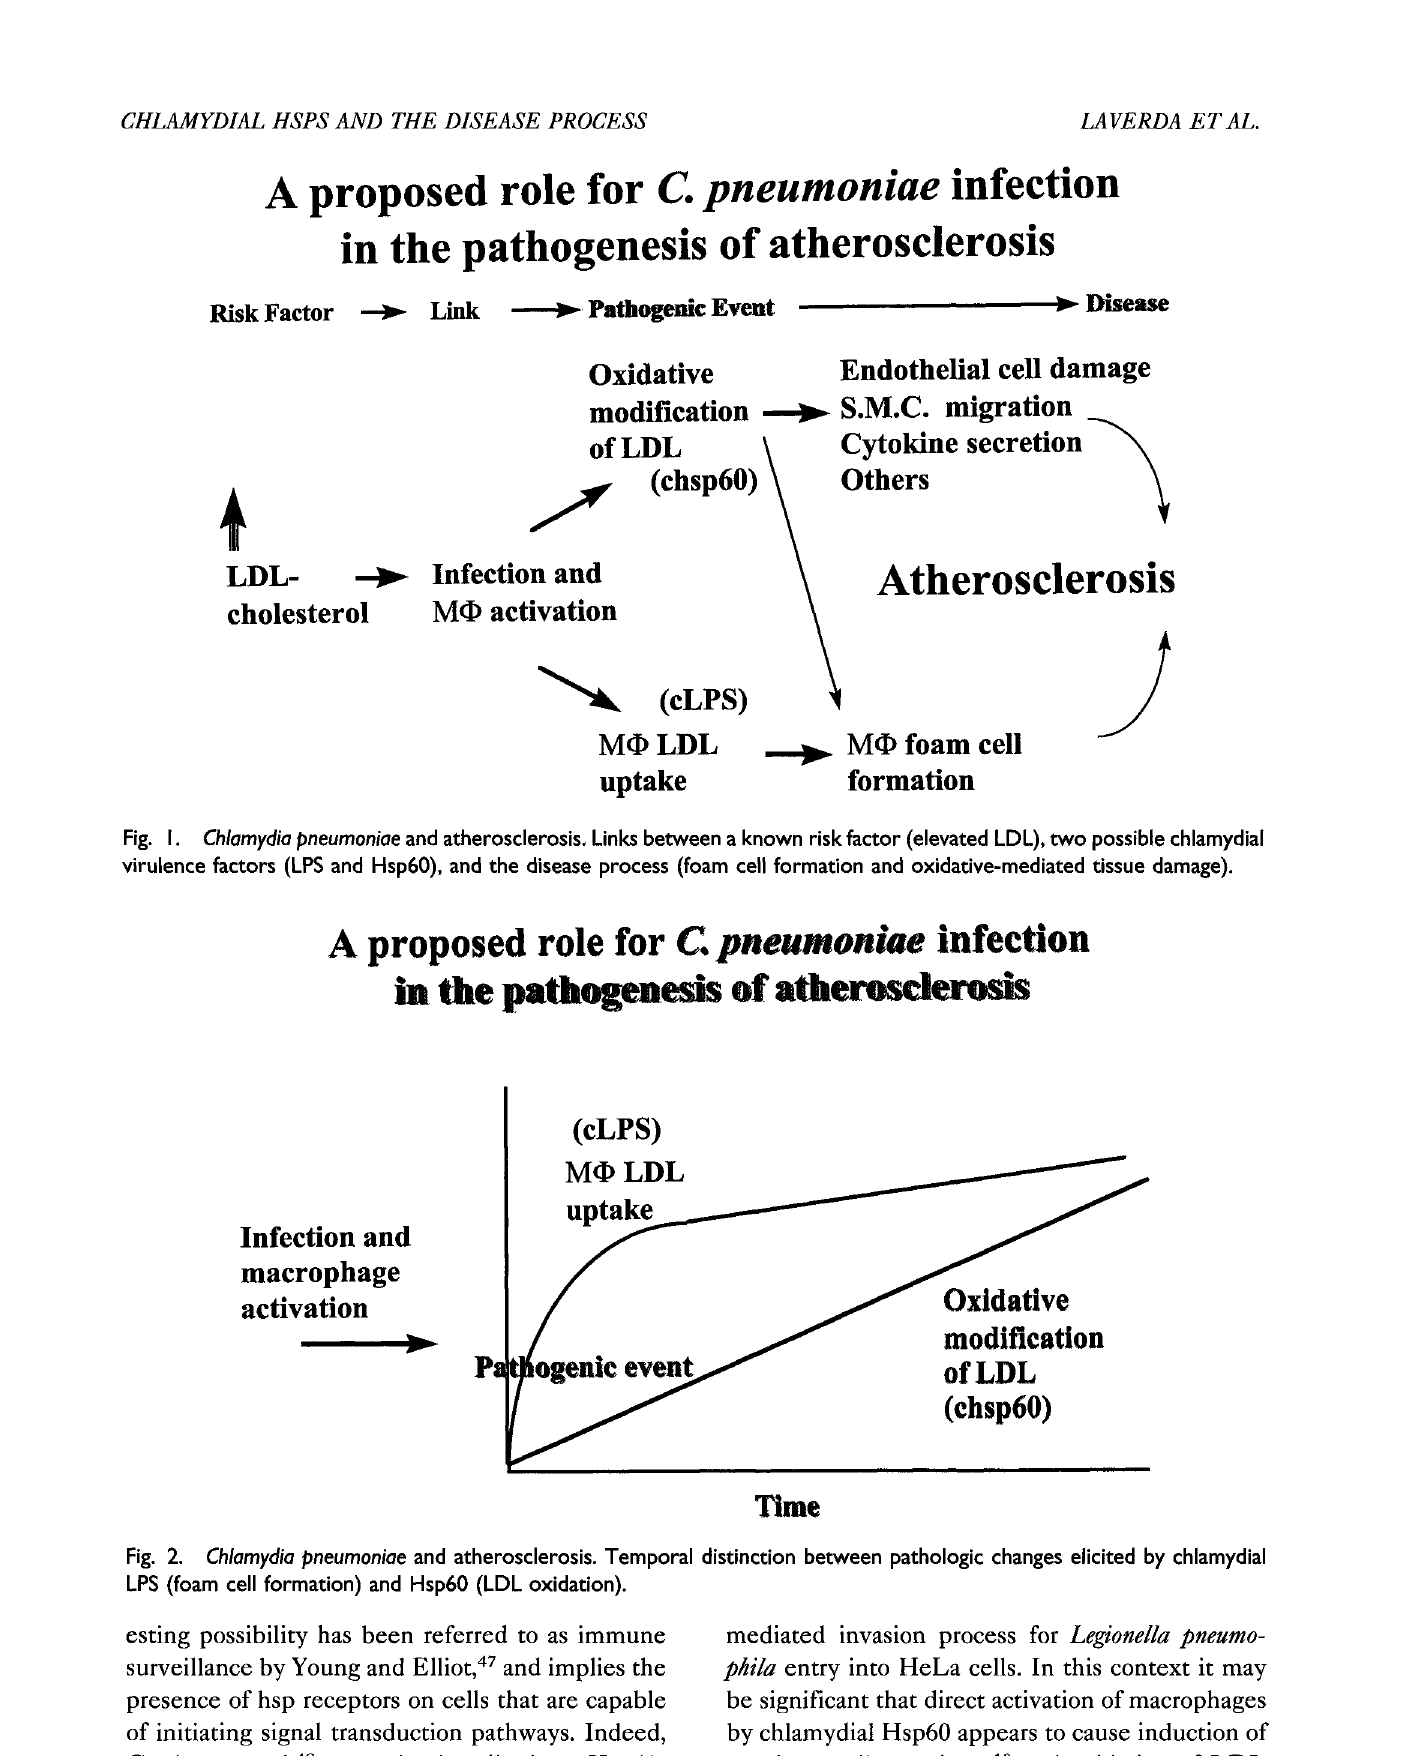
Fig. 2. Chlamydia pneumoniae and atherosclerosis. Temporal distinction between pathologic changes elicited by chlamydial LPS (foam cell formation) and Hsp60 (LDL